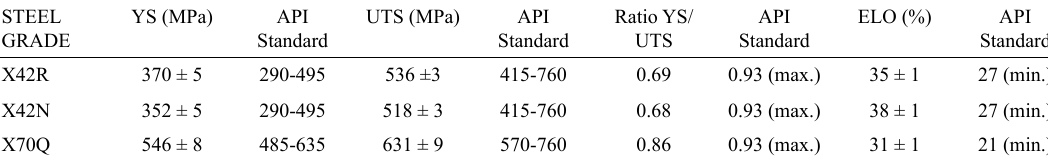
Table 2. Tensile mechanical properties of the studied steels. STEEL GRADE